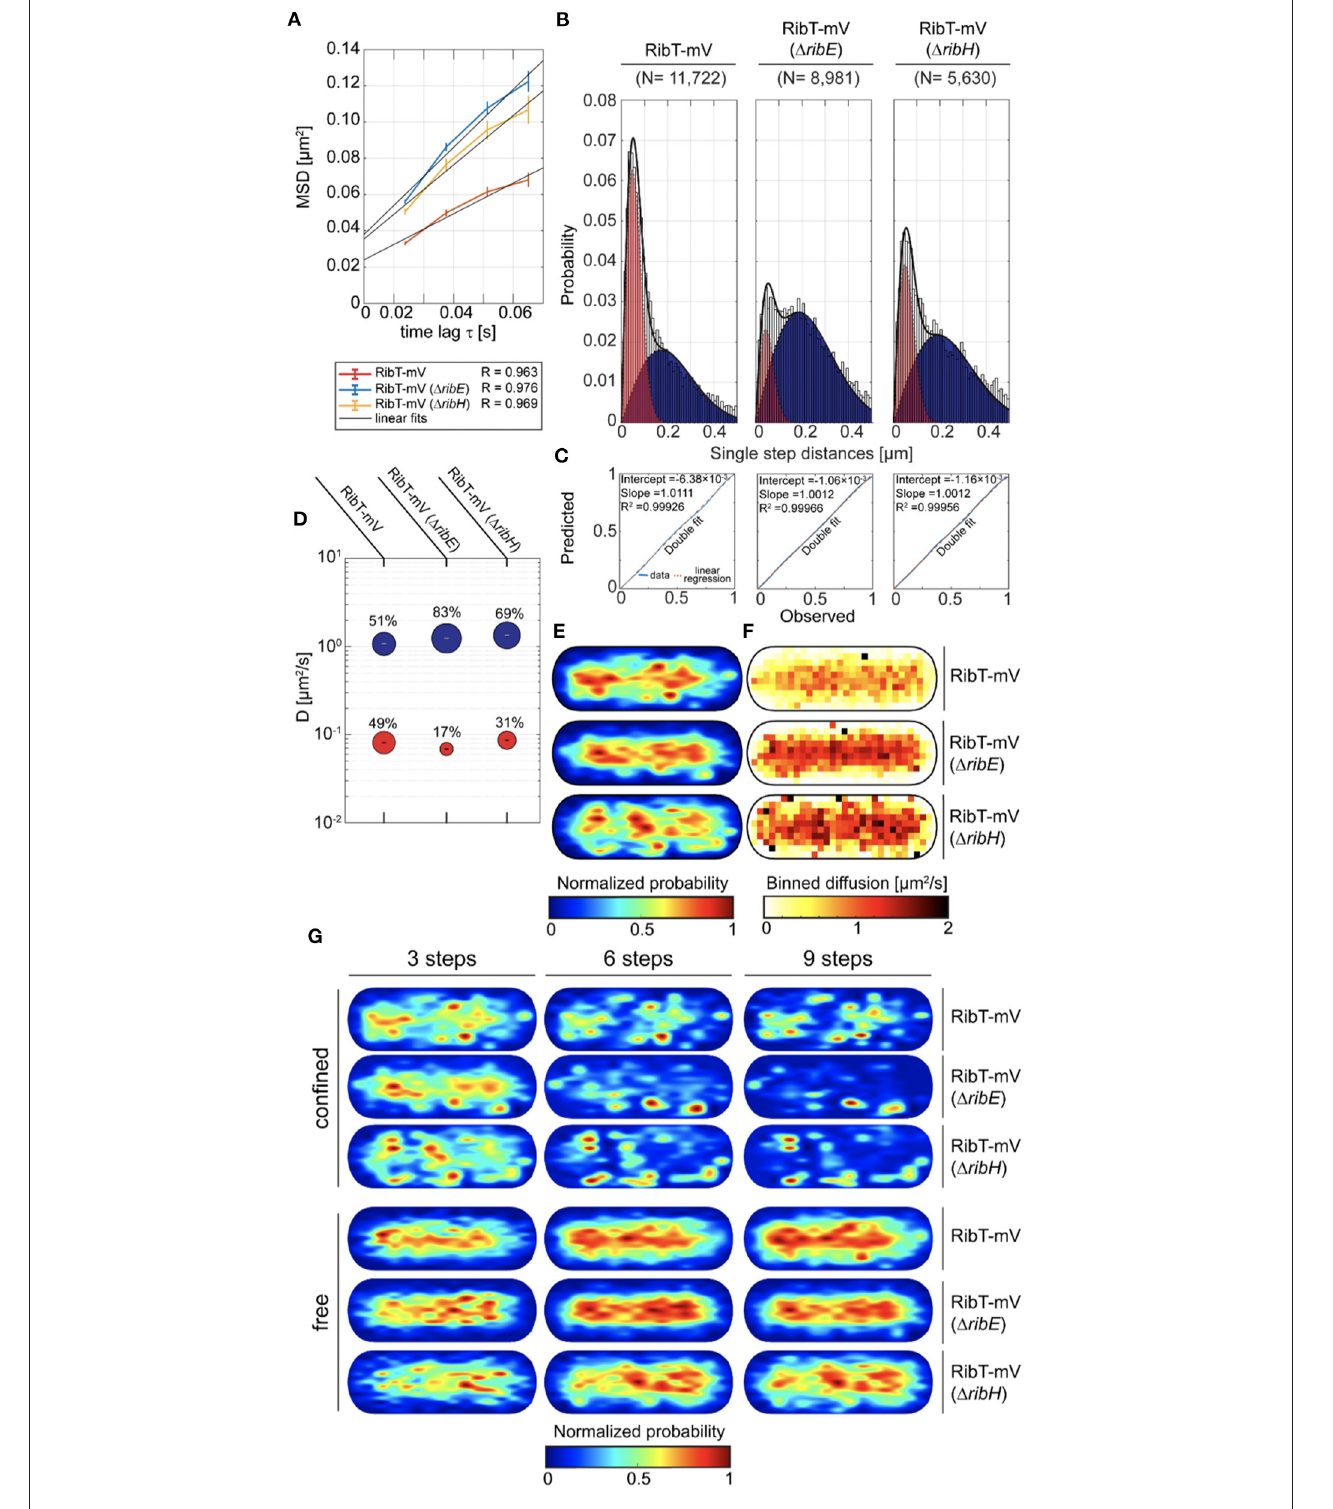
FIGURE 2 | Cytoplasmic diffusion of RibT is bipartite, revealing free and highly confined motion. (A) EAMSD vs. a time plot for RibT-mV either in the presence of RibH and RibE or with ribH or ribE gene being deleted. (B) JD analysis of RibT-mV, RibT-mV ( 1 ribH ), and RibT-mV ( 1 ribE ) SPT data using a two-component Rayleigh Mixture model. (C) Model prediction vs. observation plots for the Rayleigh Mixture models of JDs in (B) . (D) Bubble plots displaying relative proportions of